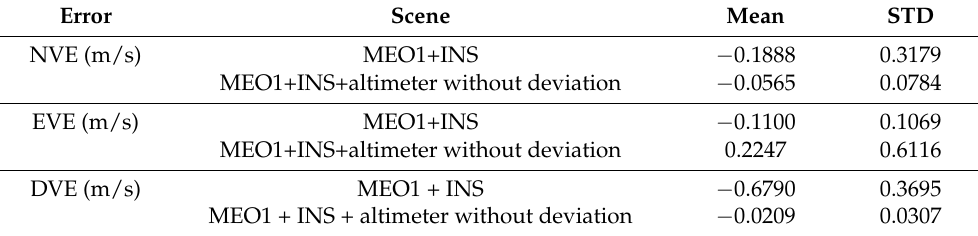
Table 9. Velocity error